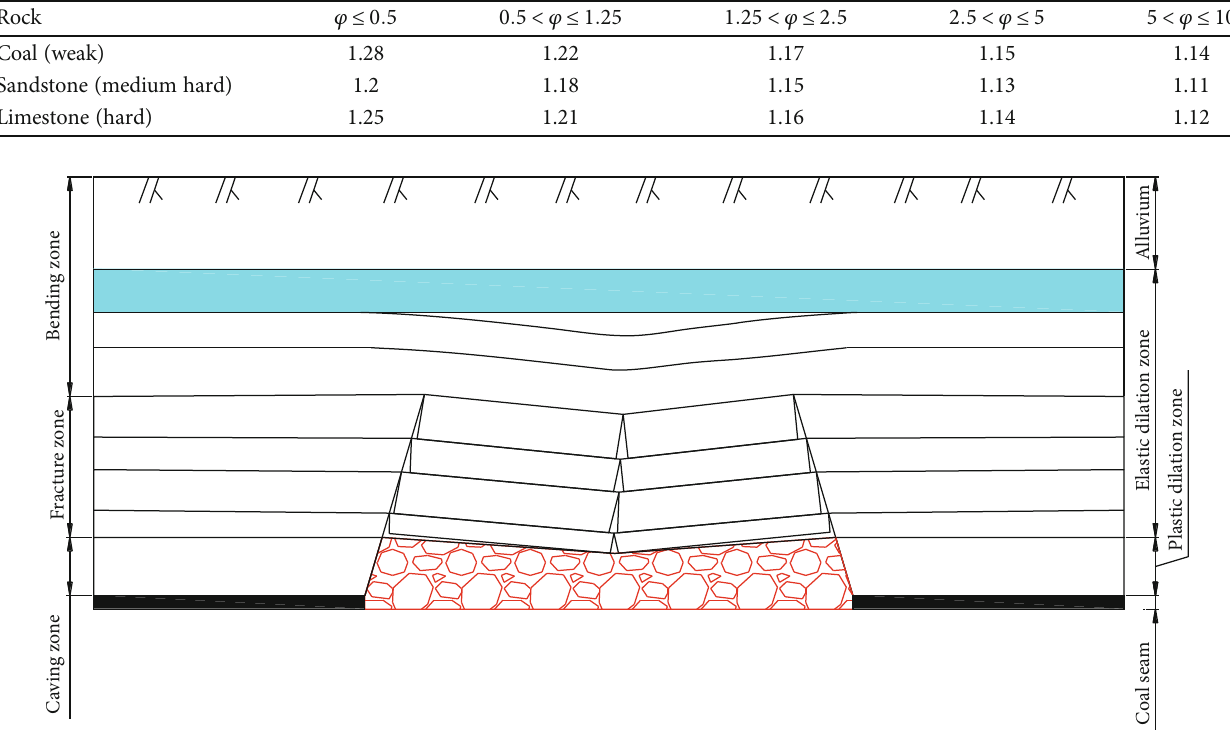
Figure 6: Diagram of three zone